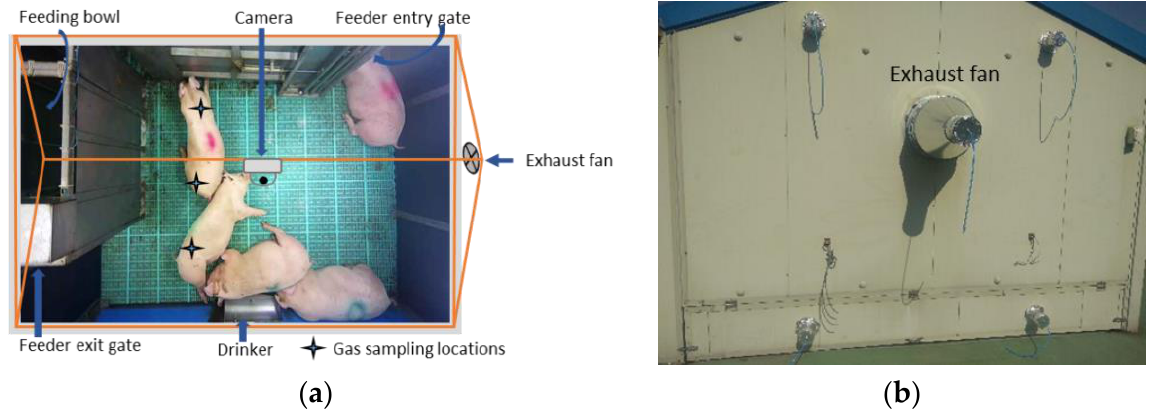
Figure 1. Experimental setup in the pig barn: ( a ) camera setup for capturing the top-view video frames and ( b ) covering of pig barn gas inlet and outlet to elevate the GHGs